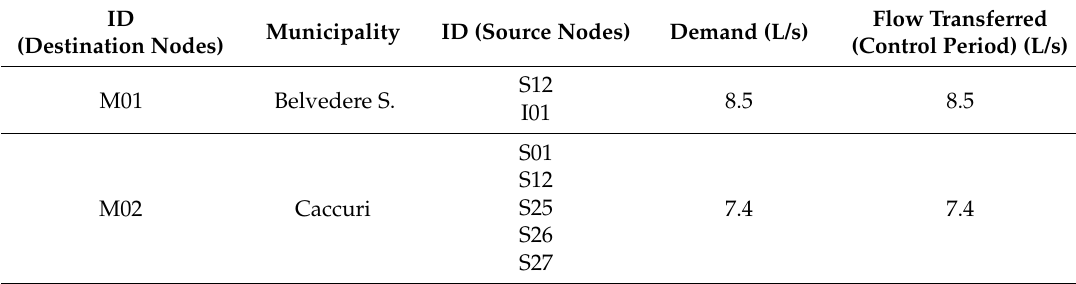
Table 4. Schematic example of the results for the control period.